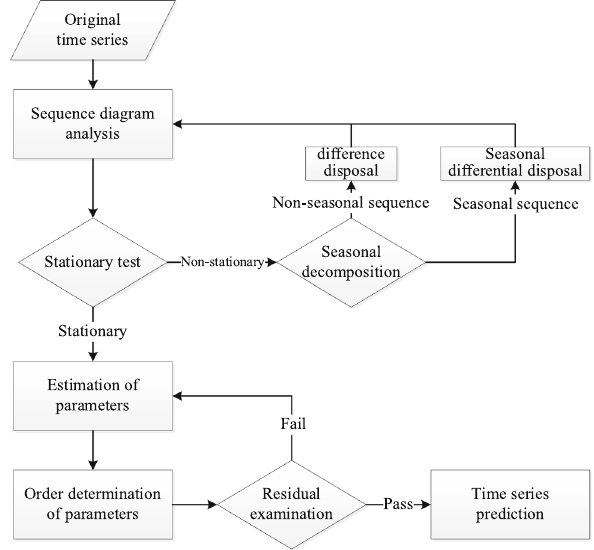
Fig. 1 The implementation process of the SARIMA